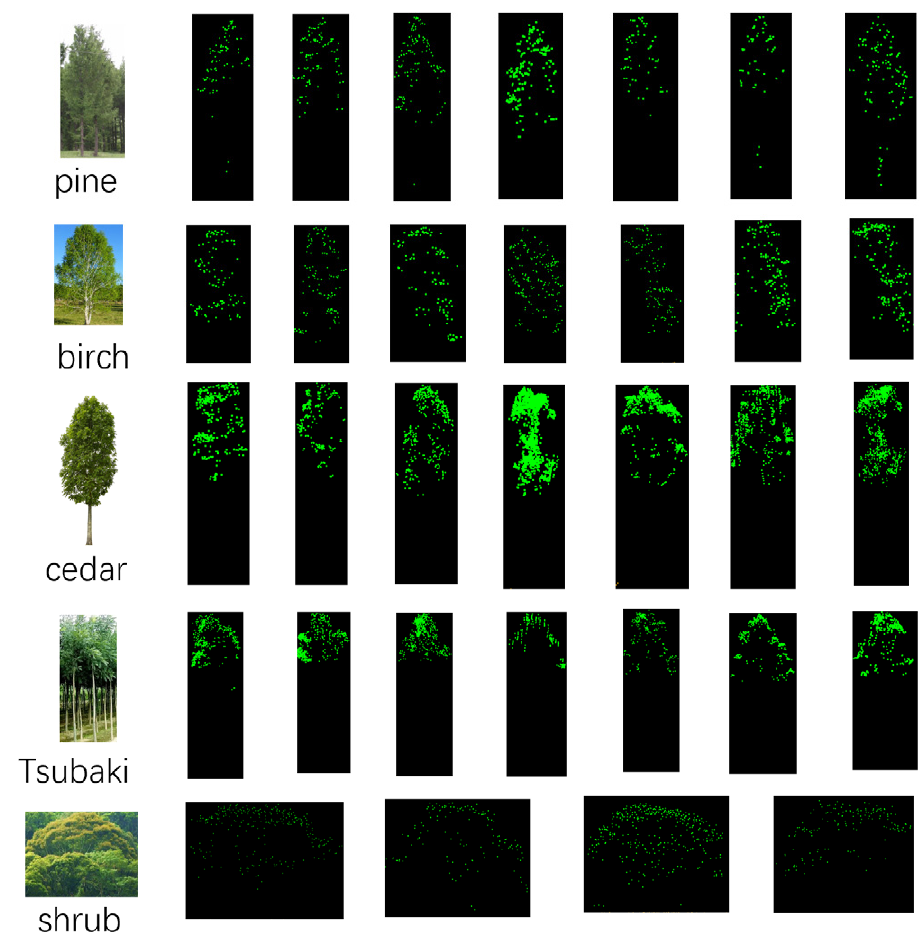
11 of 27 . Figure 8. The subsegment of the profile, and the positions of P edge and P cross .